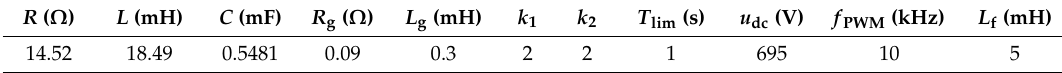
Figure 7. Three-phase simulation platform. Table 1. Parameters used in the